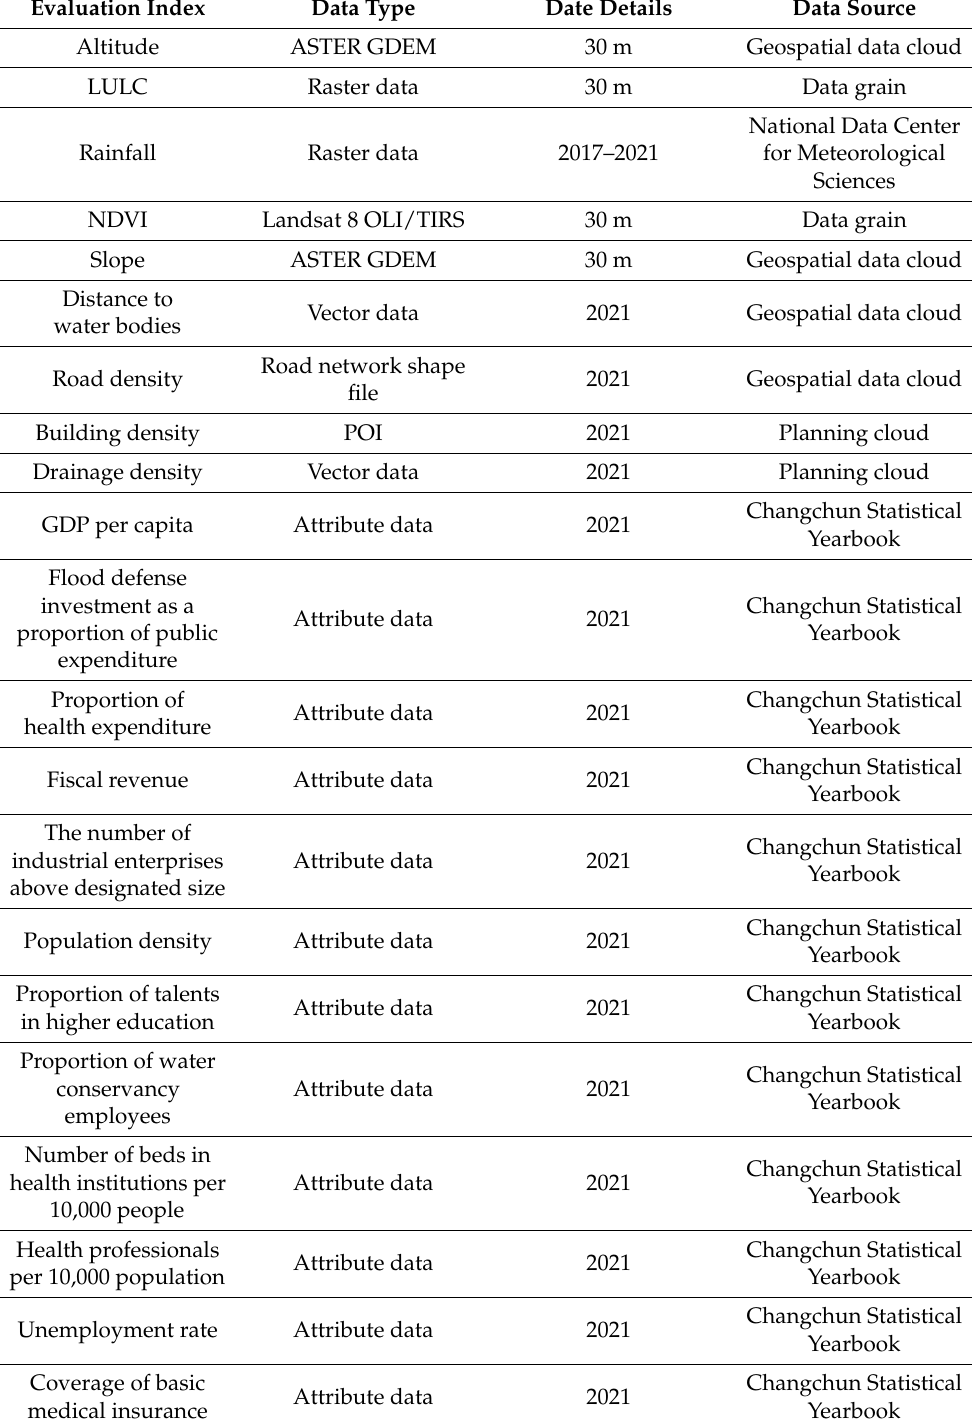
Table 2. Data types and sources of urban flood resilience evaluation